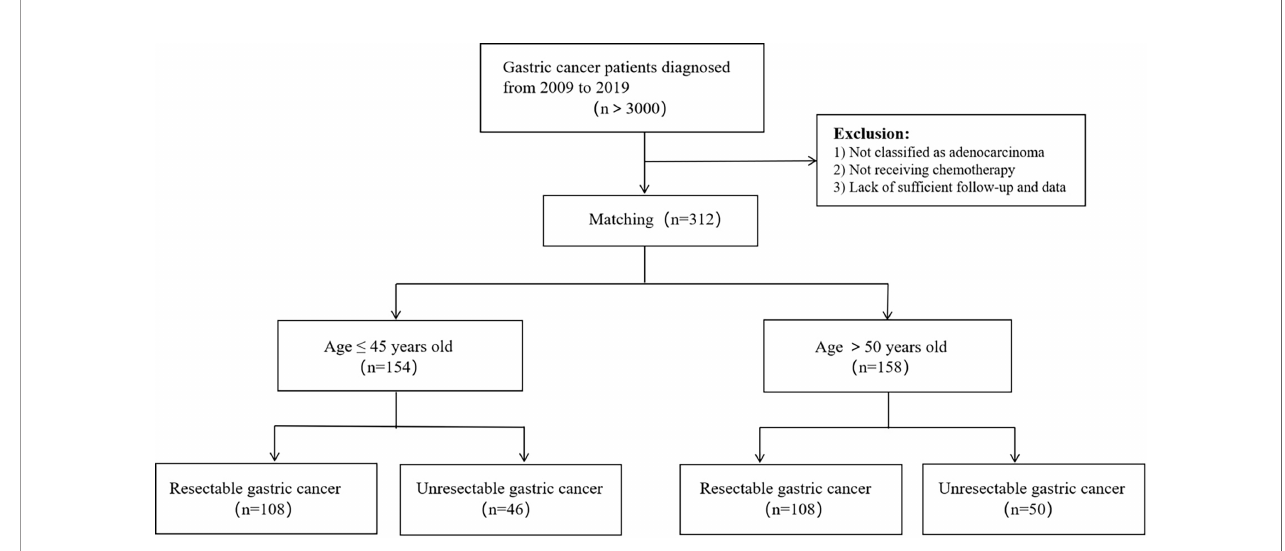
FIGURE 2 | Flowchart of the matching